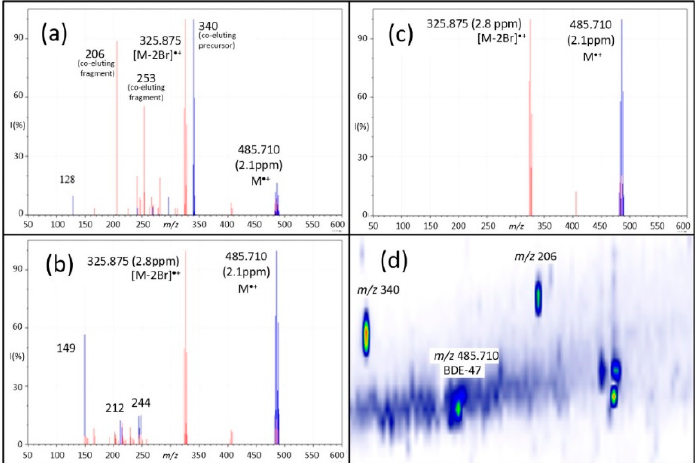
Figure 4. Comparison of ( a ) GC–DIA, ( b ) GC×GC–DIA, and ( c ) deconvolved GC–SQDIA spectra of a tetrabromodiphenyl ether. In all spectra, the low-energy channel is shown in blue and the high- energy channel is shown in red. ( d ) GC×GC–DIA chromatogram showing separation of compounds that coeluted in one-dimensional GC–DIA (as seen in ( a )). Greater separation in both GC×GC–DIA and GC–SQDIA resulted in spectra with fewer interferences than those obtained using GC–DIA; this separation can be obtained chromatographically, as in GC×GC, or utilizing the quadrupole, as in SQDIA. Adapted with permission from Schreckenbach et al. [20]. Copyright 2021 American Chemical Society.